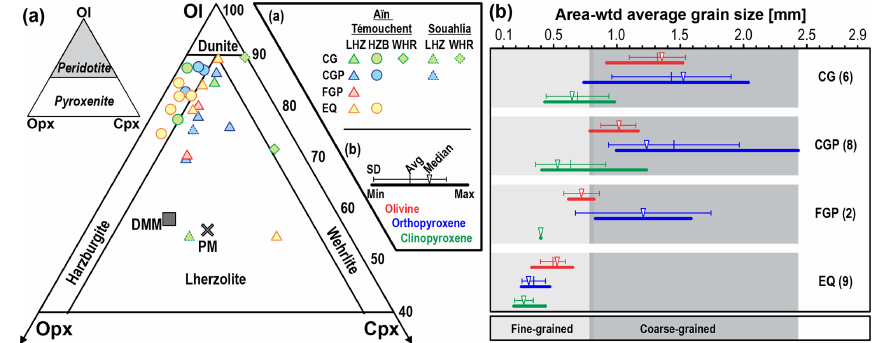
Figure 2. (a) The modal composition of the Oran mantle xenoliths in a Streckeisen diagram for ultramafic rocks (Streckeisen, 1976). DMM: depleted mid-ocean ridge basalt (MORB) mantle; PM: primitive mantle (after McDonough and Sun, 1995; Workman and Hart, 2005). (b) Distribution of area-weighted mean grain size of olivine, orthopyroxene and clinopyroxene in the Oran mantle xenoliths. Horizontal thick bars are the full range of grain sizes (from minimum to maximum) in a given textural group, thinner horizontal bars show the average with standard deviation, and white triangles indicate the median value. Numbers in brackets give the number of xenoliths in a given textural group. CG: coarse granular; CGP: coarse-grained porphyroclastic; FGP: fine-grained porphyroclastic; EQ: fine-grained equigranular; LHZ: lherzolite; HZB: harzburgite; WHR: wehrlite. See text for further